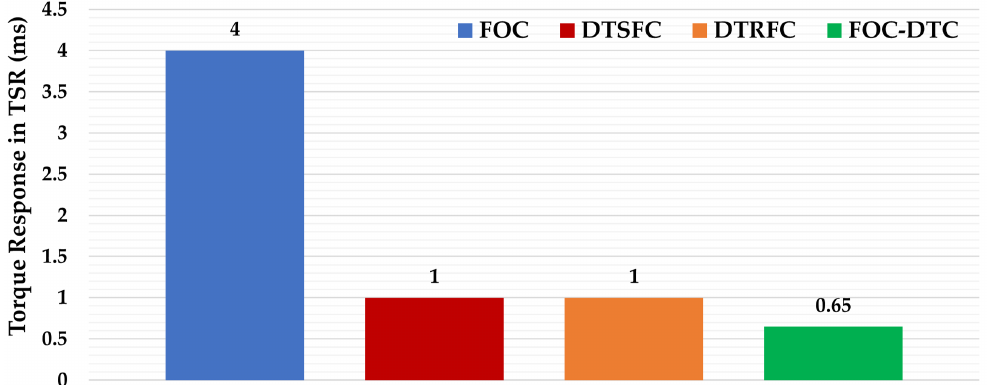
Figure 39. Comparisons of torque response in TSR for FOC, DTSFC, DTRFC, and the proposed